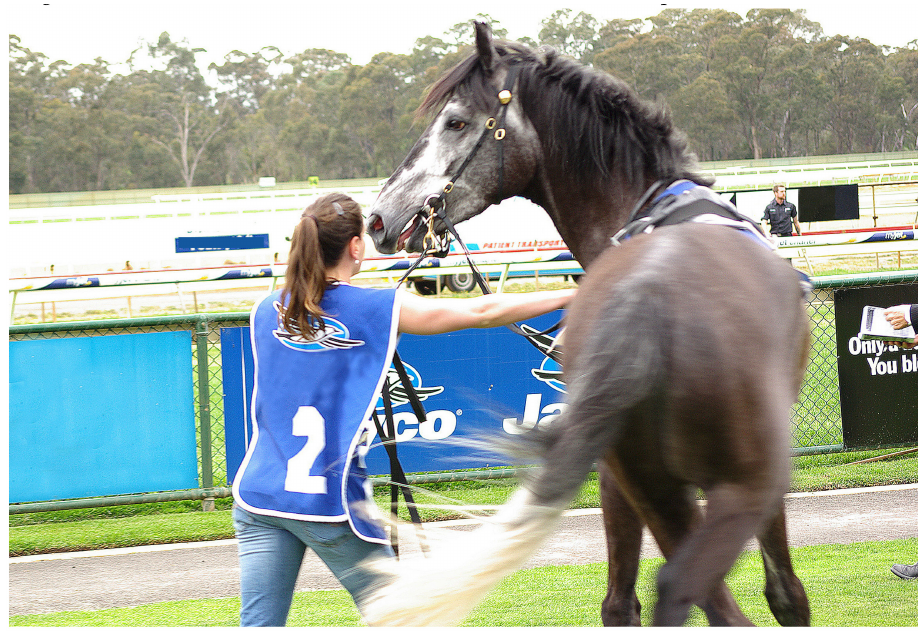
Figure 1. Image 1 for photo-elicitation